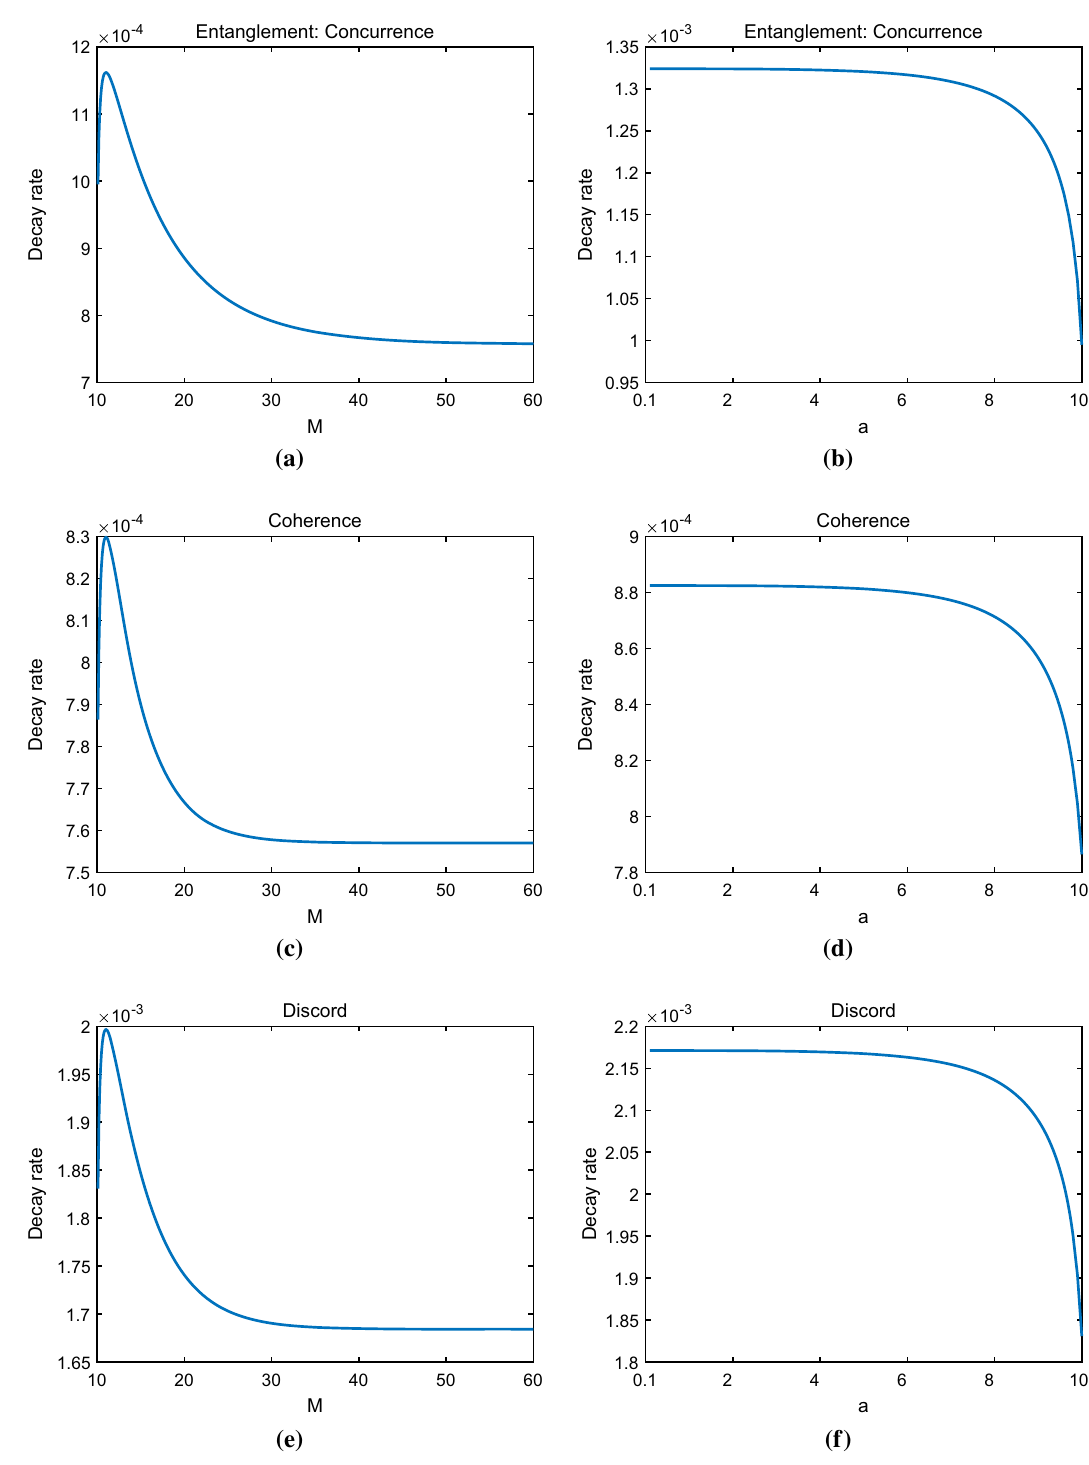
Fig. 9 The decay rates of the quantum correlations with respect to the mass when a = 10, t = 100 μ m = 10, t = 100 μ . Other parameters are the same as those in Fig. 2